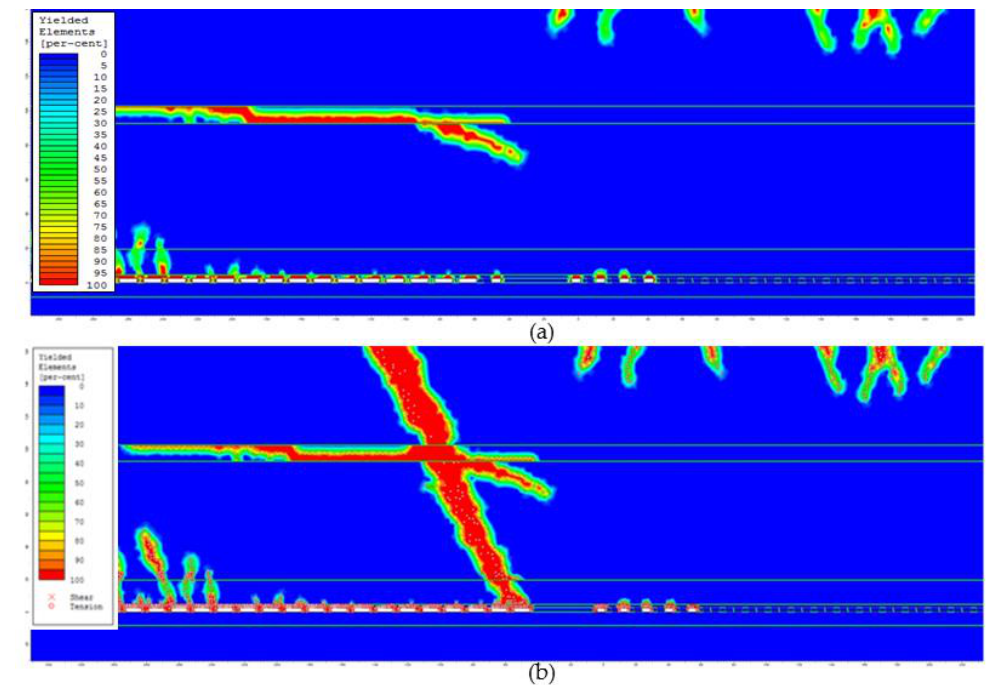
Figure 9. Yielded zones for mining front: ( a ) approximately 50 m from the remnant edge — 34th calculation step, ( b ) approximately 60 m from the remnant edge — 35th calculation step [11].